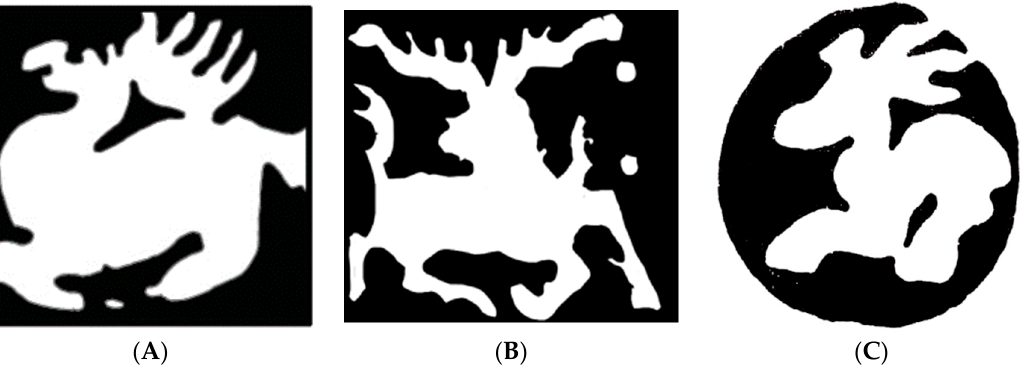
Figure 1. ( A ) A Xiaoxingyin with a reindeer motif. The Warrior States Period. Inventory number: